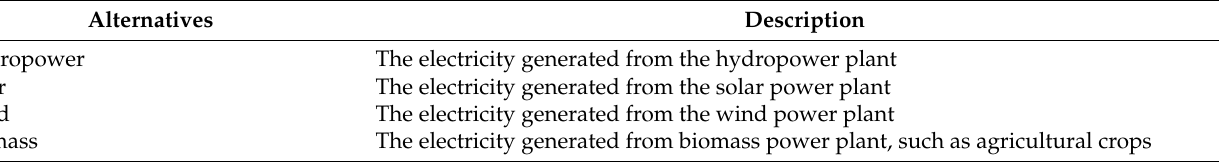
Table 1. Description of the main criteria, sub-criteria, and RE